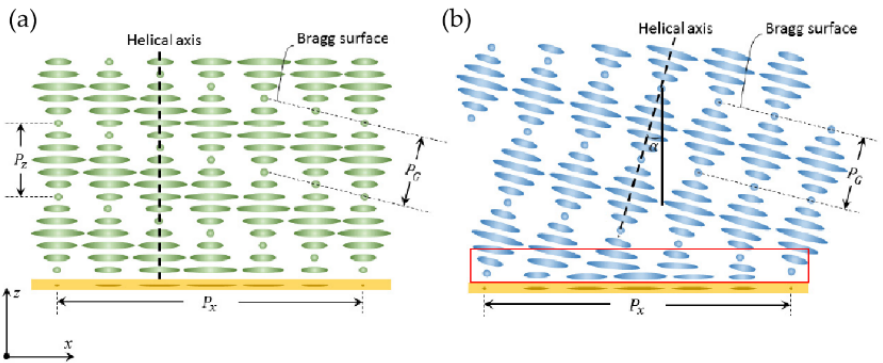
Figure 13. Different LC director structures of ( a ) planar-PVG and ( b ) slanted-PVG. According to the latest research, the real configuration of LC director in PVG tend to be slanted like (b) [14].